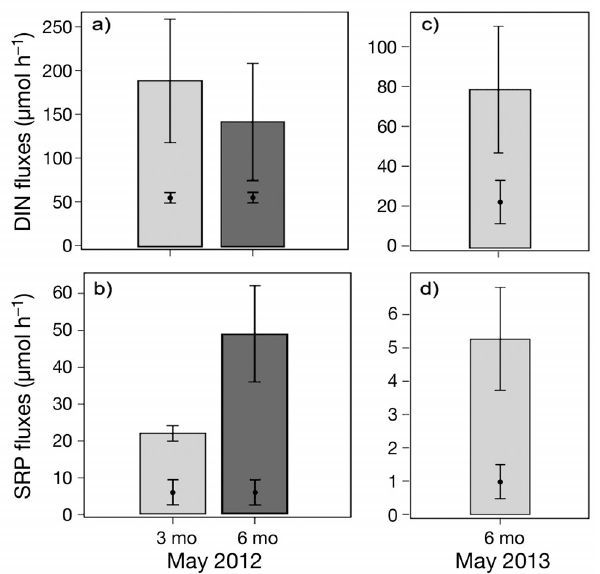
Fig. 5. Mean (±SD) dissolved inorganic nitrogen (DIN) and soluble reactive phosphorus (SRP) fluxes measured in (a,b) Mangareva and (c,d) Ahe for each treatment (light grey bar: ropes with 3 mo of biofouling development [CR3]; dark grey bar: ropes with 6 mo of biofouling development [CR6]; black dots: clean pearl oysters) Table 4. Student’s t -test for the effect of treatment (colonized ropes or cleaned pearl oysters) on measured fluxes in Ahe and Mangareva. Bold values are significant values at p < 0.05. DIN = dissolved inorganic nitrogen; SRP =